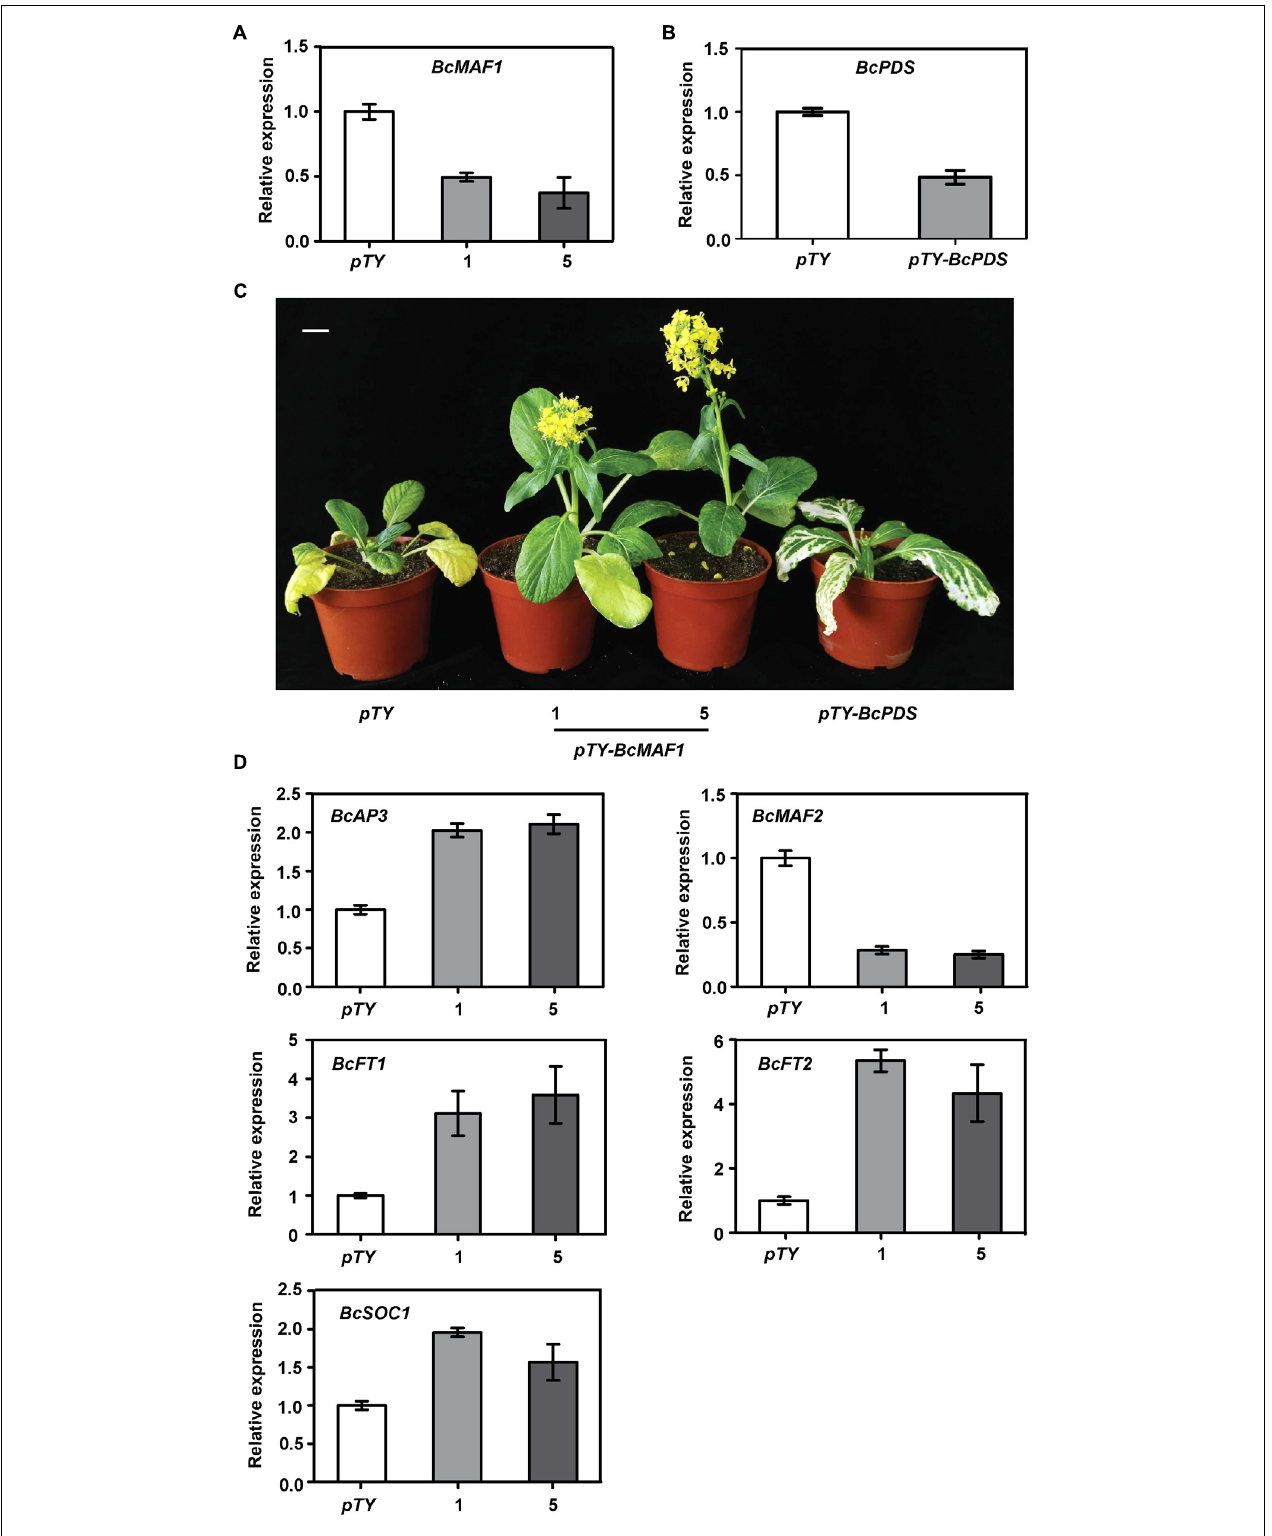
FIGURE 4 | Silencing BcMAF1 in Pak-choi. (A) Expression analysis of BcMAF1 in Pak-choi seedlings bombarded with pTY and pTY-BcMAF1 plasmid. (B) Expression analysis of BcPDS in Pak-choi seedlings bombarded with pTY and pTY-BcPDS plasmid. (C) Early flowering phenotype in Pak-choi seedlings silenced BcMAF1 . Scale bars = 2.5 cm. (D) Expression analysis of predicted downstream genes in the pTY , pTY-BcMAF1-1 , and pTY-BcMAF1-5 plants.